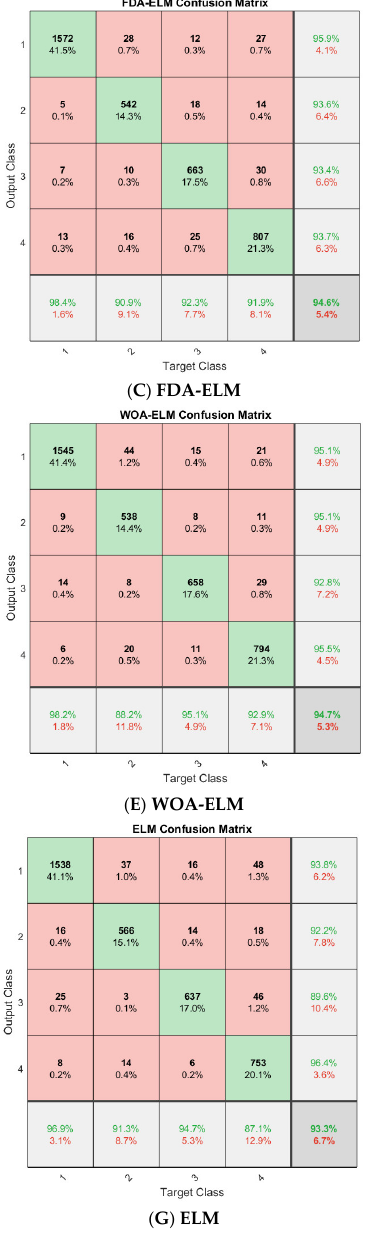
Figure 13. Confusion matrix (URPC) of each algorithm, including DenseNet201 ( A ), FCMFDA-ELM ( B ), FDA-ELM ( C ), STOA-ELM ( D ), WOA-ELM ( E ), MFO-ELM ( F ), and ELM ( G ).